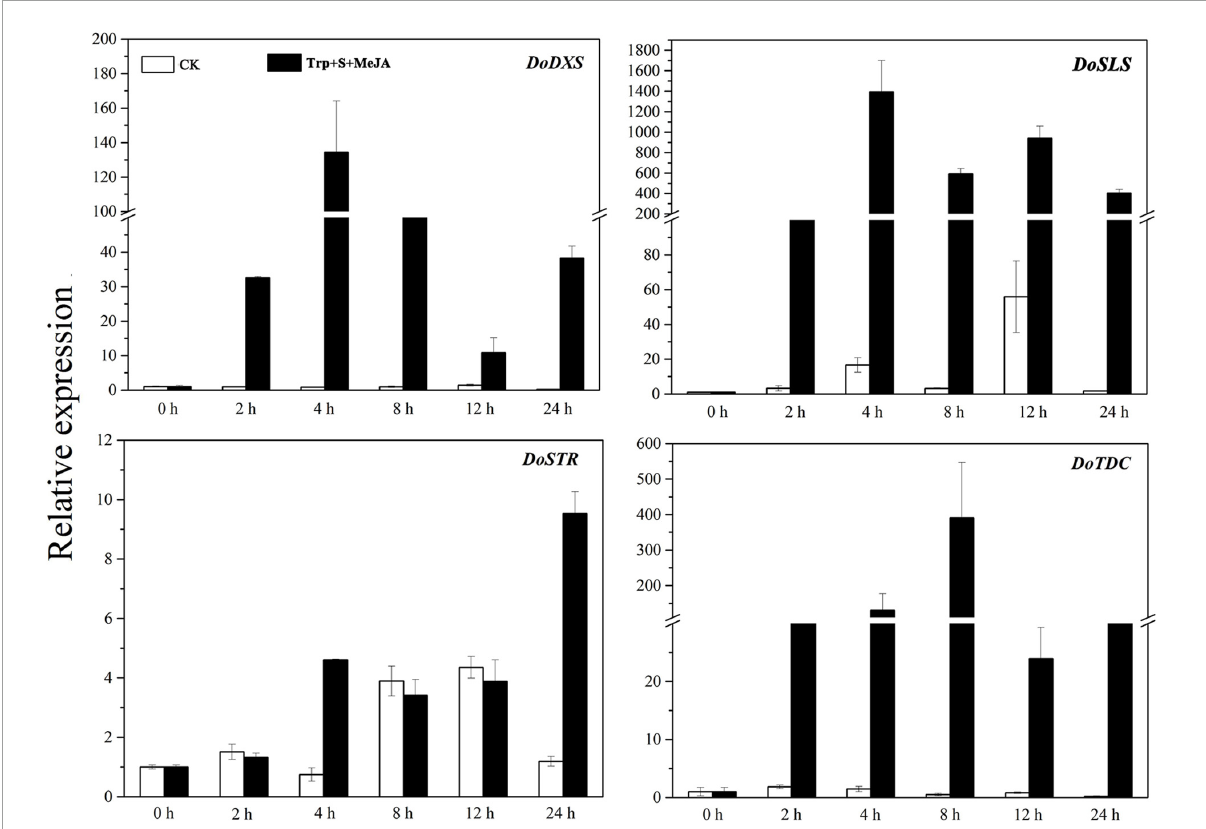
FIGURE2 Expression patterns of four key genes involved in the TIA biosynthetic pathway of D. officinale PLBs under precursor and MeJA